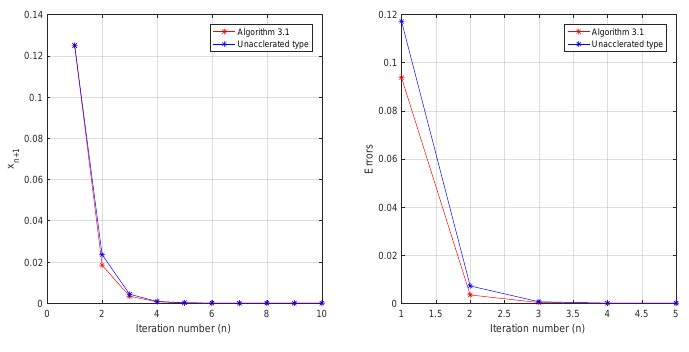
Figure 2: x 1 = 0.1250 , Left: accuracy against number of iterations; Right: errors against numbers of iterations.